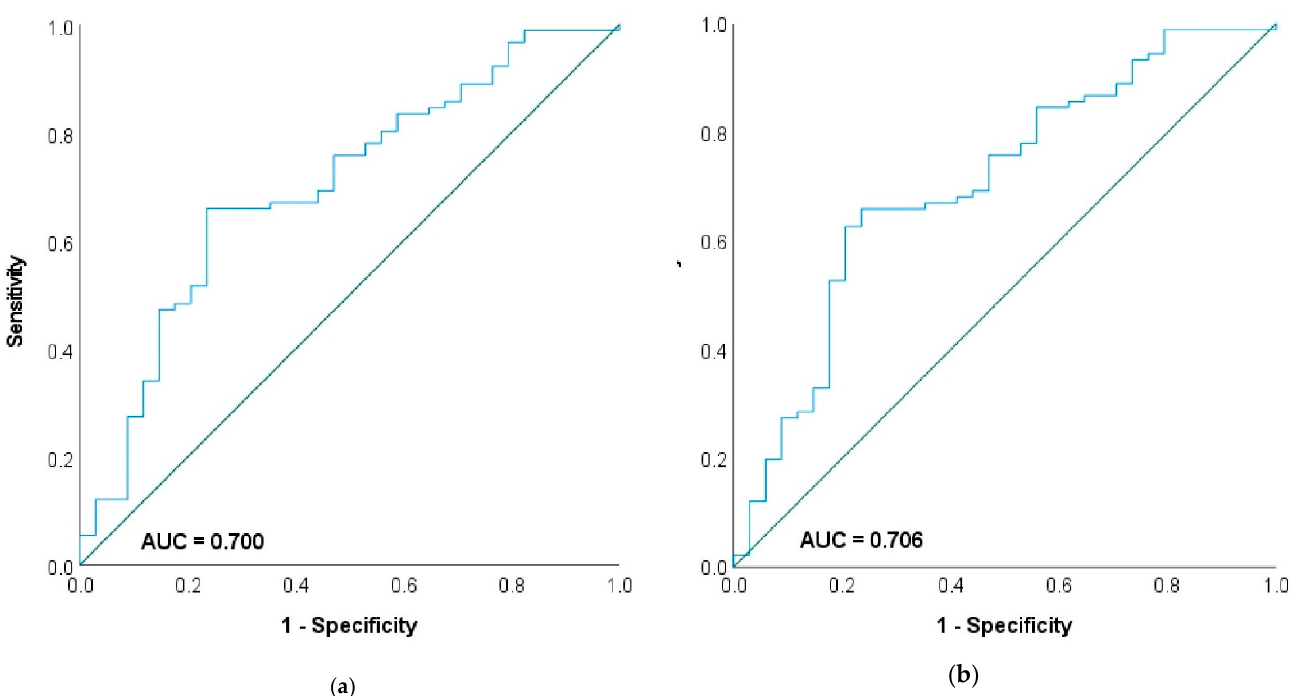
Figure 2. Receiver operating characteristic (ROC) analysis depicting the predictive value of the Fibrinogen-Albumin-Ratio (FARI) for a progression free survival (PFS) < 6 months ( a ) and disease-specific survival (DSS) < 12 months ( b ).